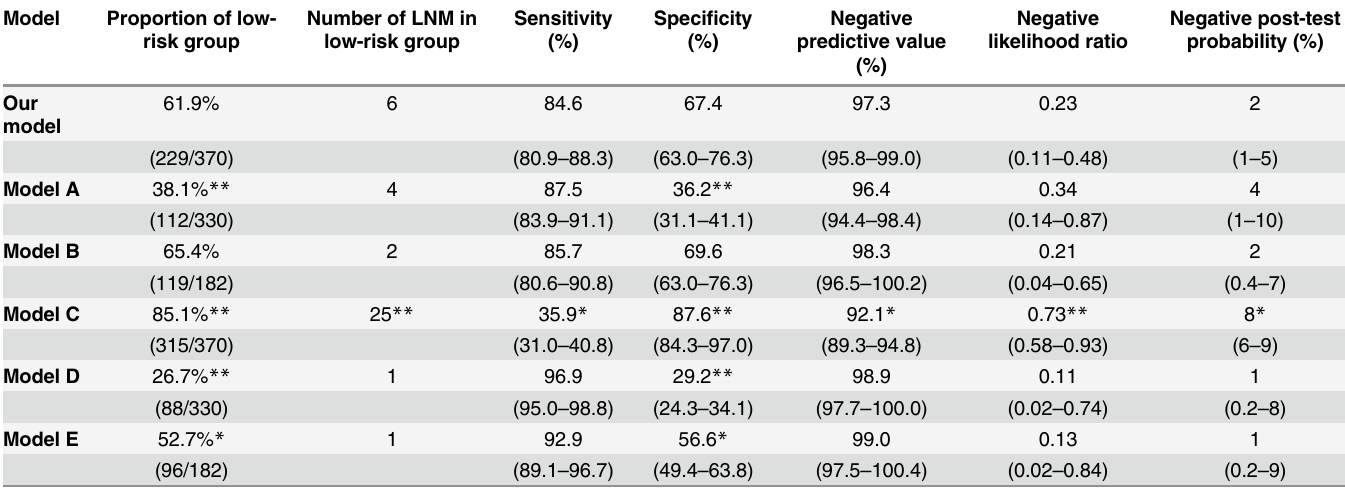
Table 5. Comparison of predictive performance in different prediction models.